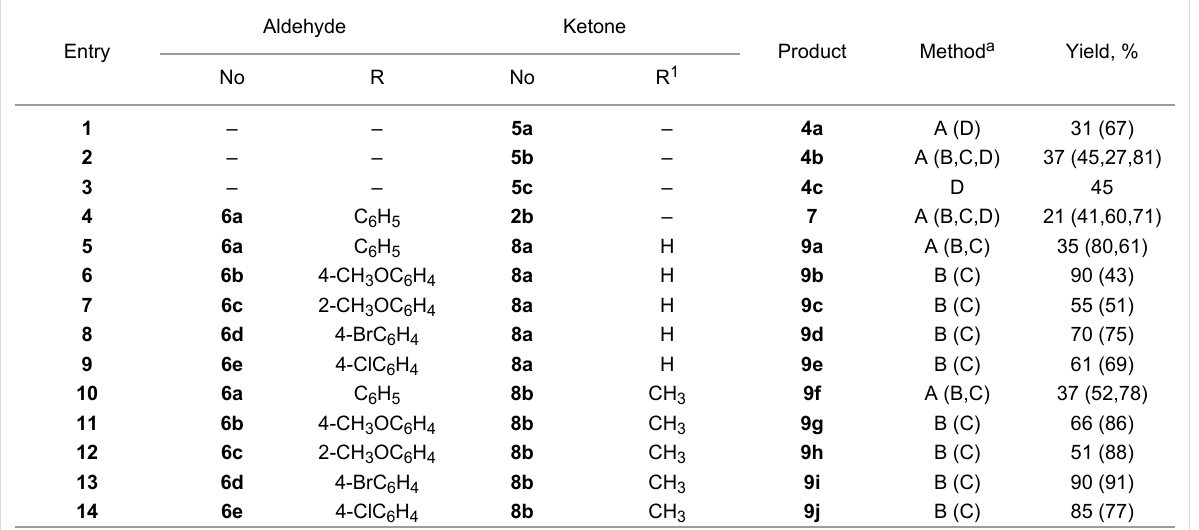
Table 1: Multicomponent synthesis of 4,5,6,7,8,9-hexahydro[1,2,3]triazolo[5,1- b ]quinazoline-3-carboxamides 4a – c , 7 and 9a – j . Aldehyde Entry